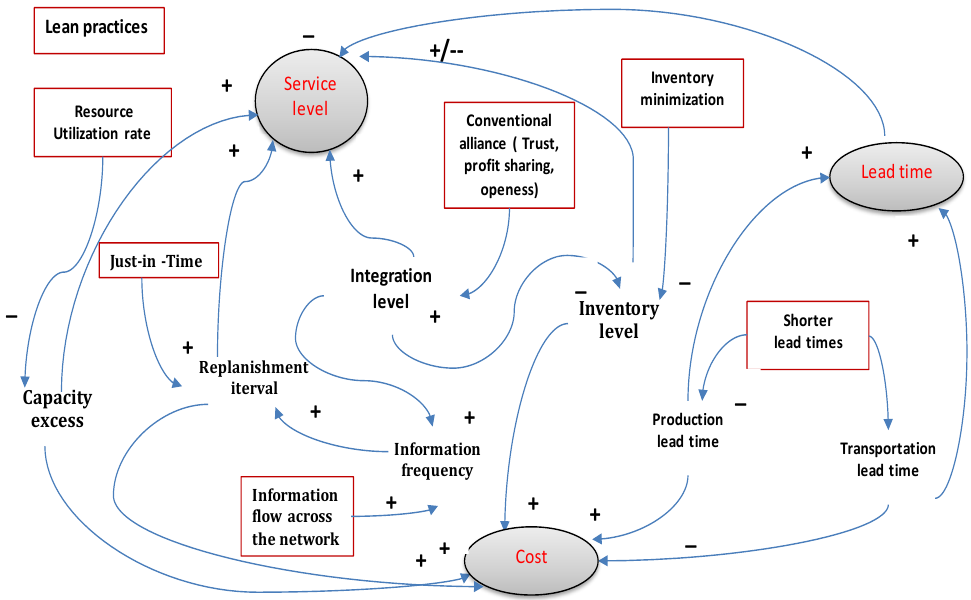
Figure 2. Lean inventory attributes and supply chain performance relationships